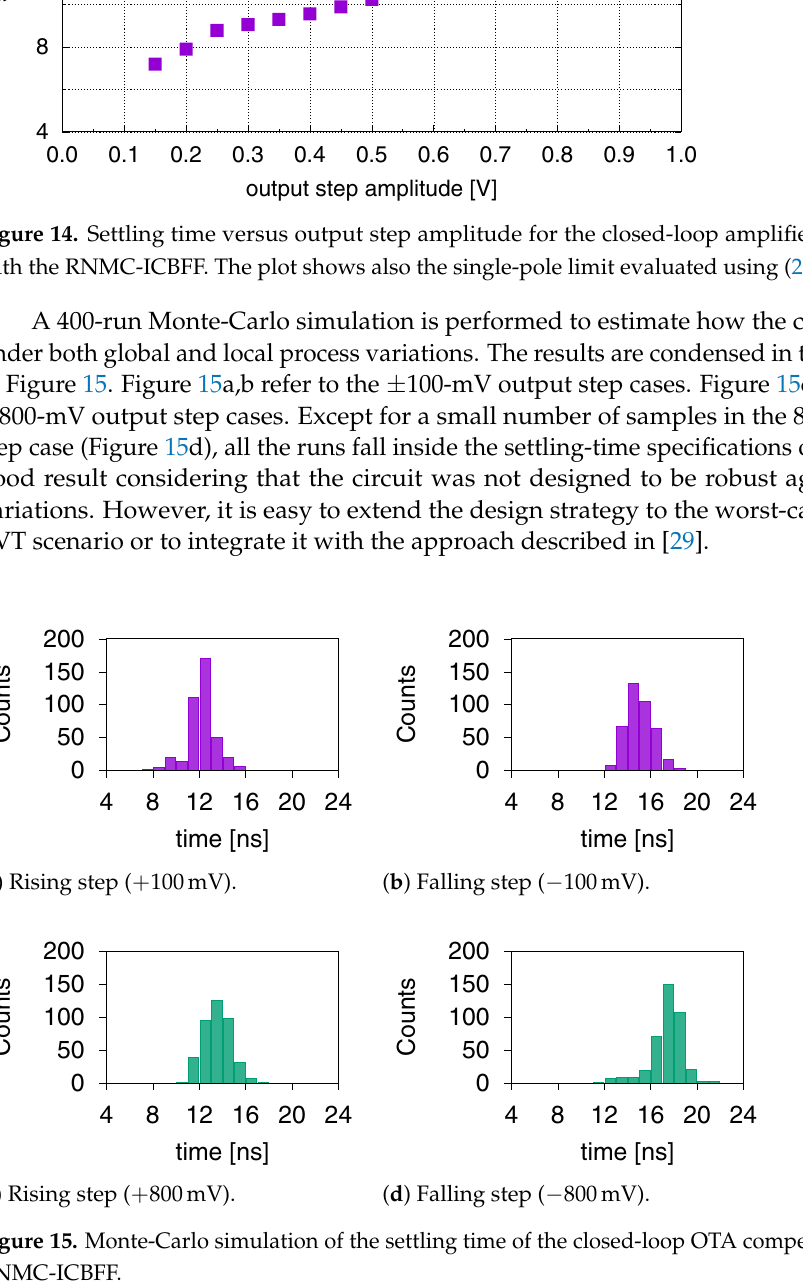
Figure 15. Monte-Carlo simulation of the settling time of the closed-loop OTA compensated with the